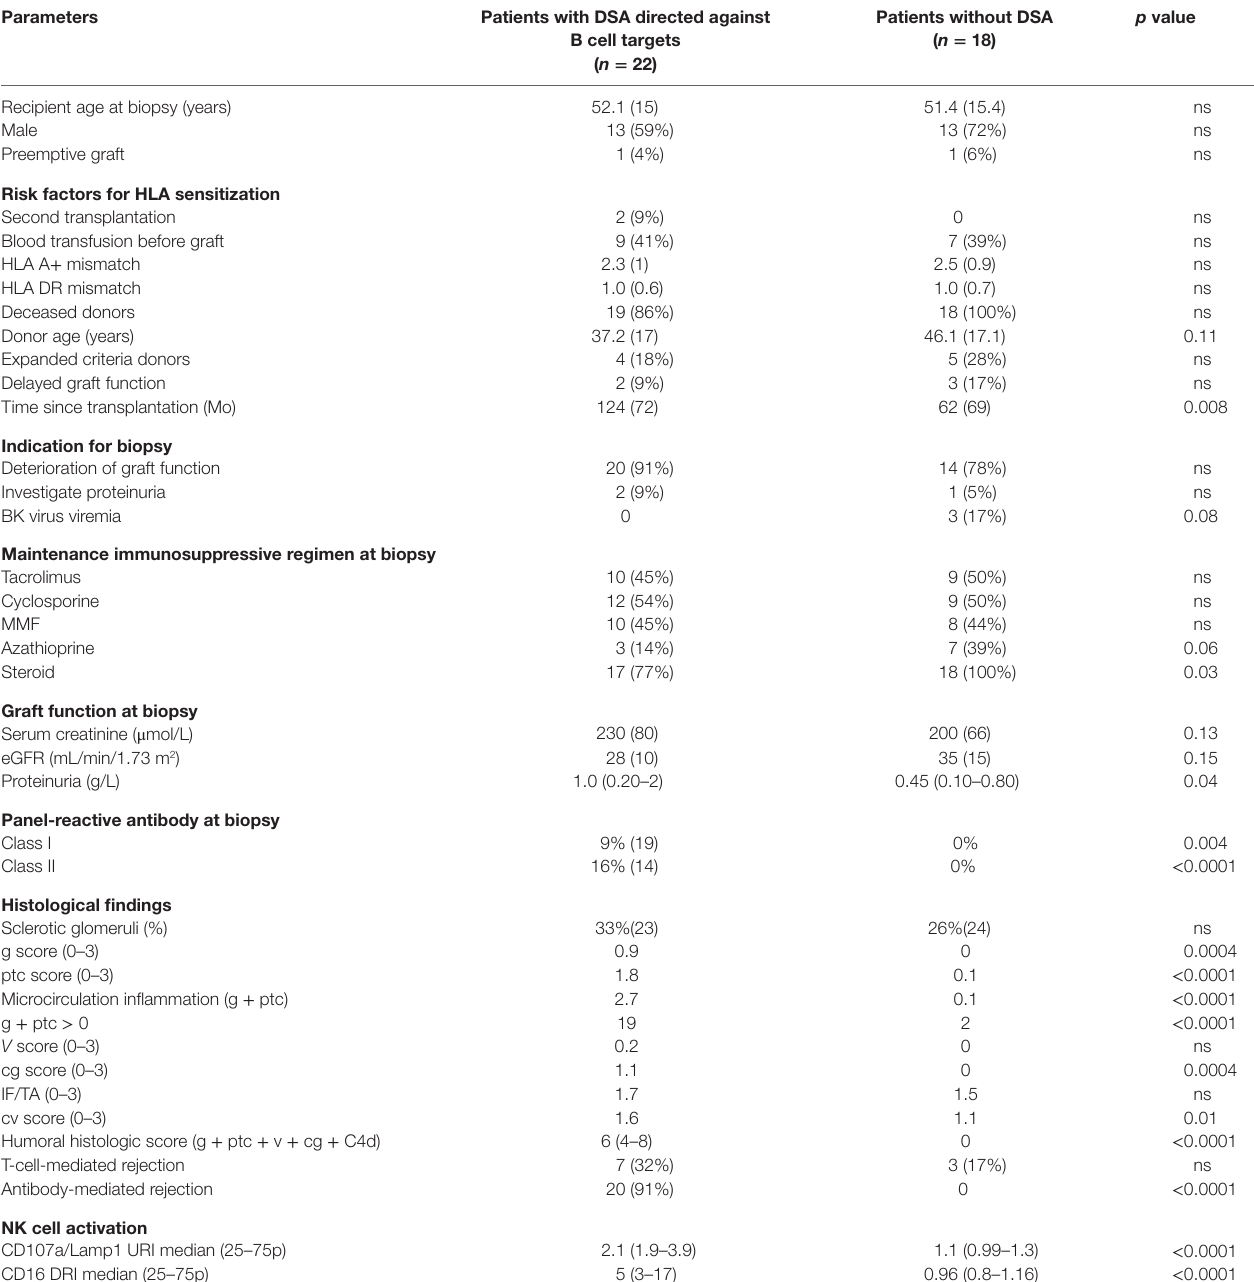
TaBle 3 | characteristics and histological Banff scores of the 40 patients subjected to evaluation of the serum cD16Dri obtained at the time of histological diagnosis.